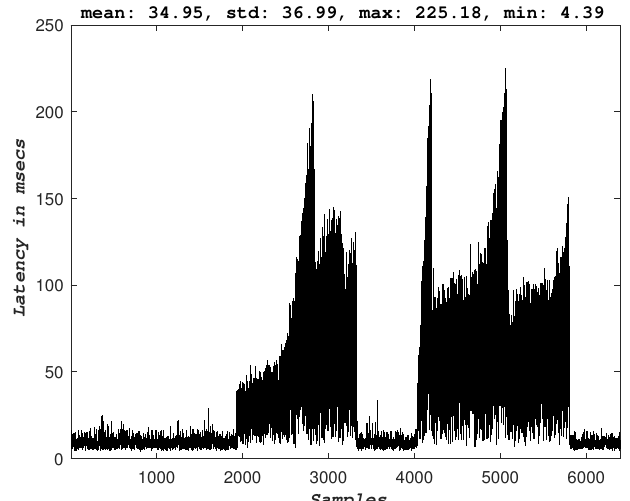
Figure 8. The downlink latency of the 5G-UAV. Sensor offloading on the same 5G-UAV platform is turned on and off two times.